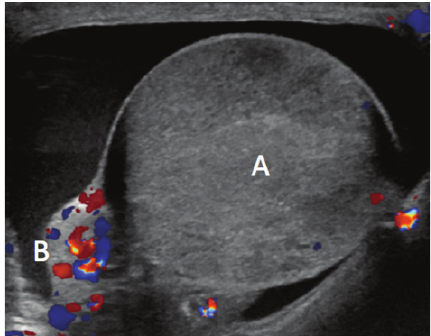
Figure 2: Right scrotal ultrasound with color Doppler interrogation onday7ofhospitalizationshowingA:rightmarkedlyheterogeneous testis with blood flow essentially absent; B: prominent, hyperemic right epididymis.